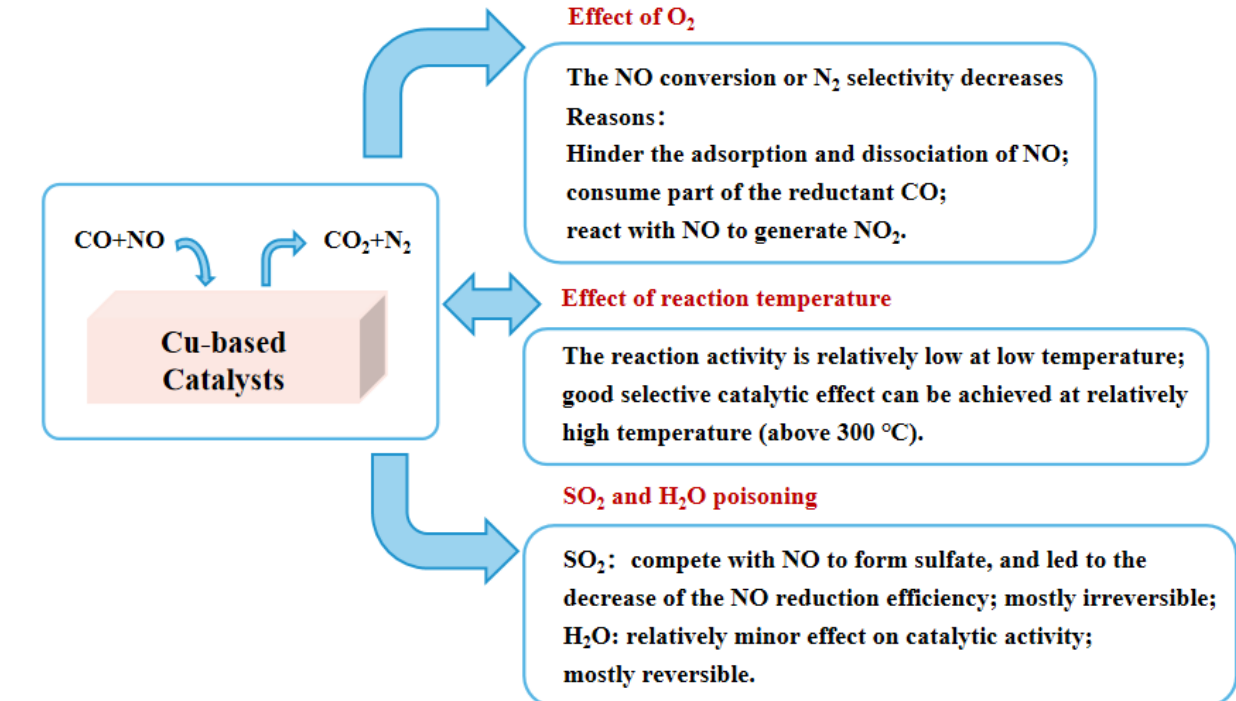
Figure 4. Effect of O 2 , reaction temperature, SO 2 , and H 2 O on the catalytic activity of Cu-based catalysts for NO reduction by CO.